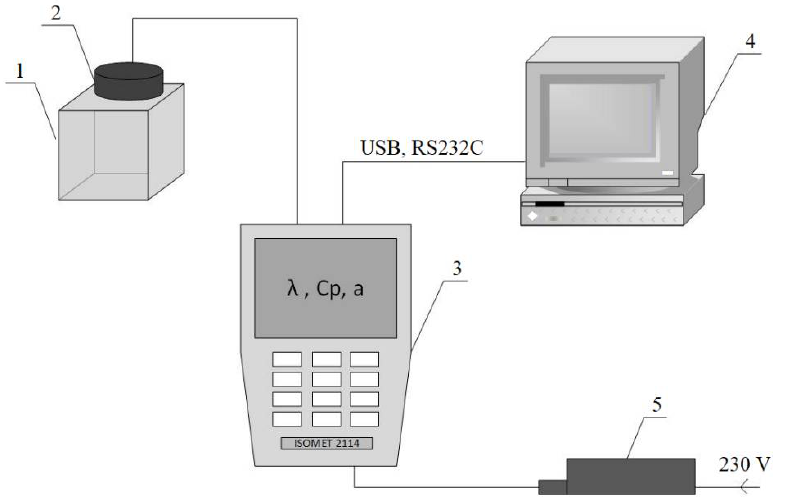
Figure 4. Scheme of the experimental stand for measuring the thermal properties of the building materials [30,31]: 1—tested sample, 2—probe, 3—Isomet 2114 device, 4—computer, 5—power supply.